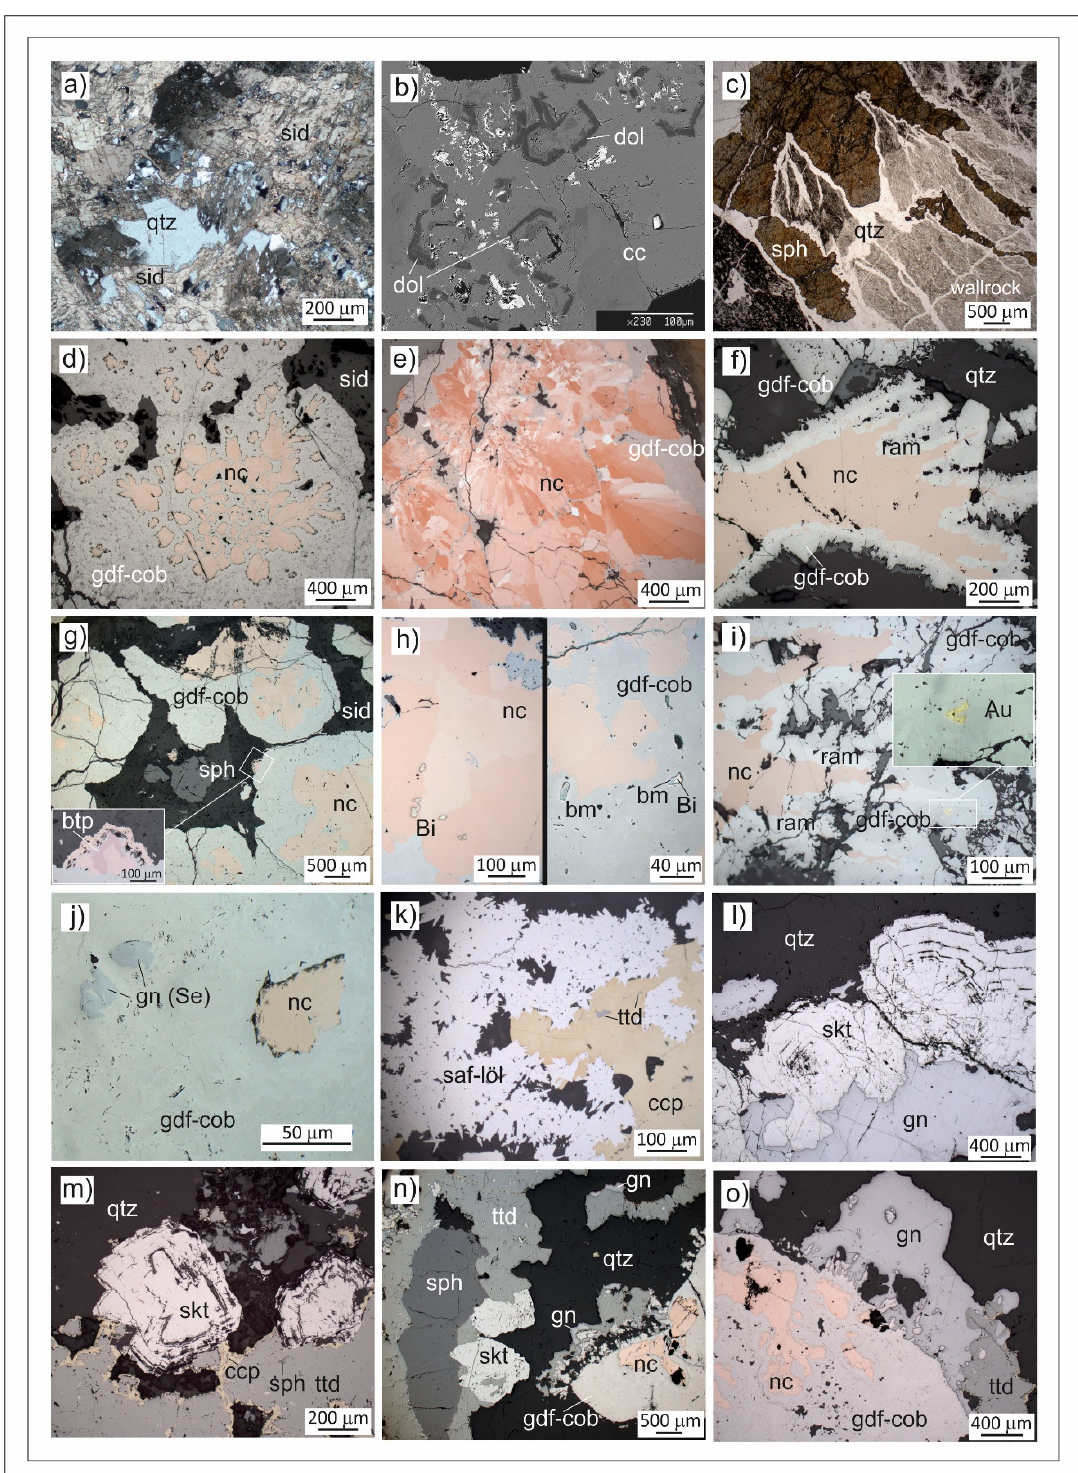
Figure 4. Microscopic features of the mineralization from the SW Sardinian veins. ( a ) Symplectite-like intergrowths of quartz and euhredral siderite associated with Ni–Co arsenide nodules—Pira Inferida. ( b ) Late-stage calcite cement accompanying sphalerite mineralization and enclosing skeletal dolomite—Sa Menga. ( c ) Brecciated, silicified shaly wallrock cemented by quartz and sphalerite, brown-Sa Menga. ( d ) Ni–Co-rich nodules with niccolite cores overgrown by Ni–Co sulfarsenide-rich cockades—Acqua Is Prunas. ( e ) Radial to plumose structure of the niccolite cores—Sa Menga (crossed nicols). ( f ) Ni–Co-rich aggregates with wide niccolite interior and rims of rammelsbergite (inner) and Ni–Co sulfarsenides (outer)—Pira Inferida. ( g ) Ni–Co-rich nodules with niccolite cores and thick Ni– Co sulfarsenide-rich cockades, with external breithauptite aggregate and sphalerite in carbonate